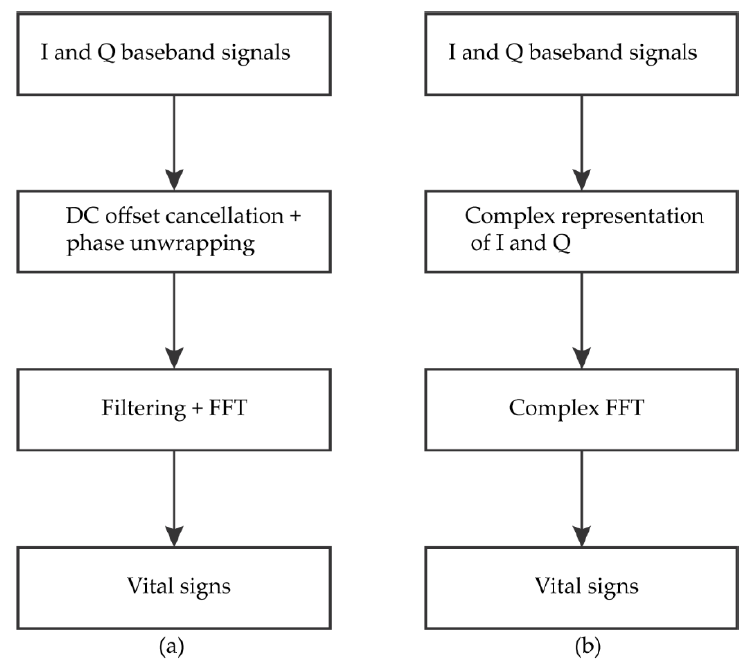
Figure 10. Flow chart of ( a ) arctangent demodulation (AD) signal processing and ( b ) complex signal demodulation (CSD) signal processing.